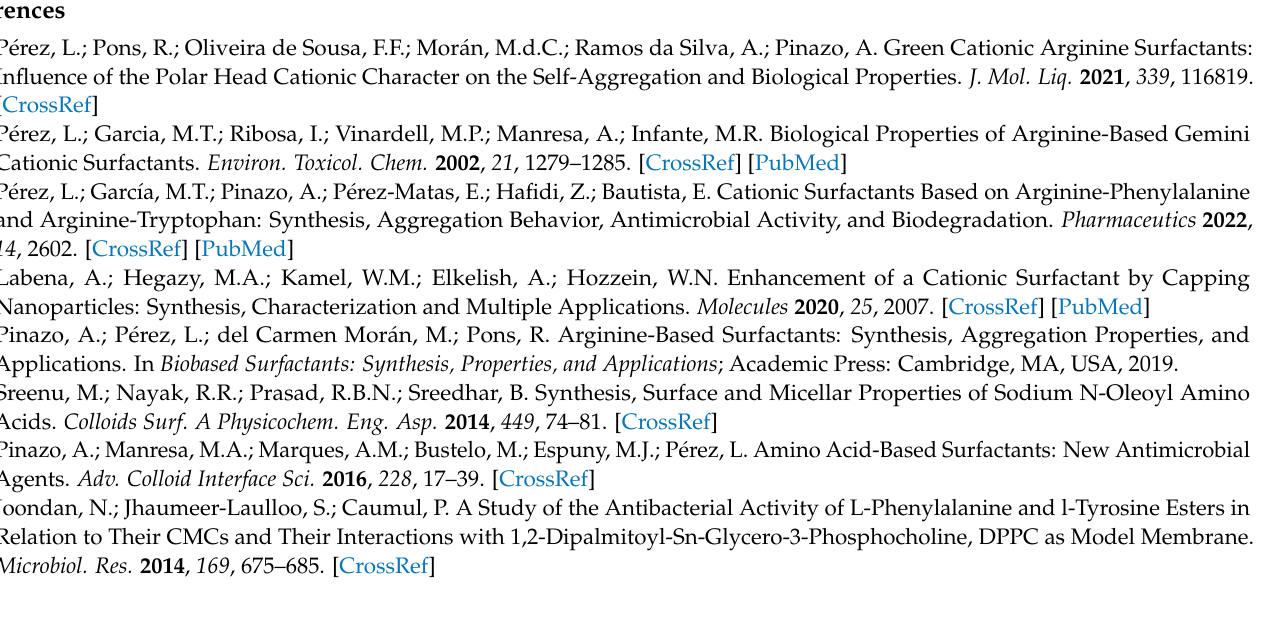
(Q9SYT3_MAIZE), Table S3: Results of interaction details and docking score in (kJ/mol) of C 12 PAM ligand complexed in different binding sites on the surfaces on the zein structures (Q9SYT3_MAIZE), Table S4: Results of interaction details and docking score in (kJ/mol) of PANHC12 ligand complexed in different binding sites on the surfaces on the zein structures (Q9SYT3_MAIZE). Figure S1: Canonical forms of guanidine